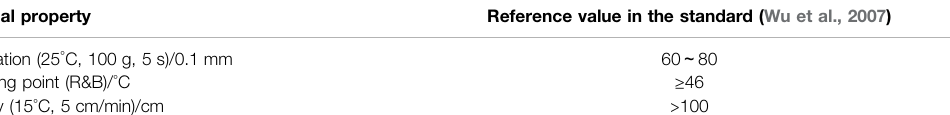
TABLE 1 | Speci fi cations of the asphalt matrix.